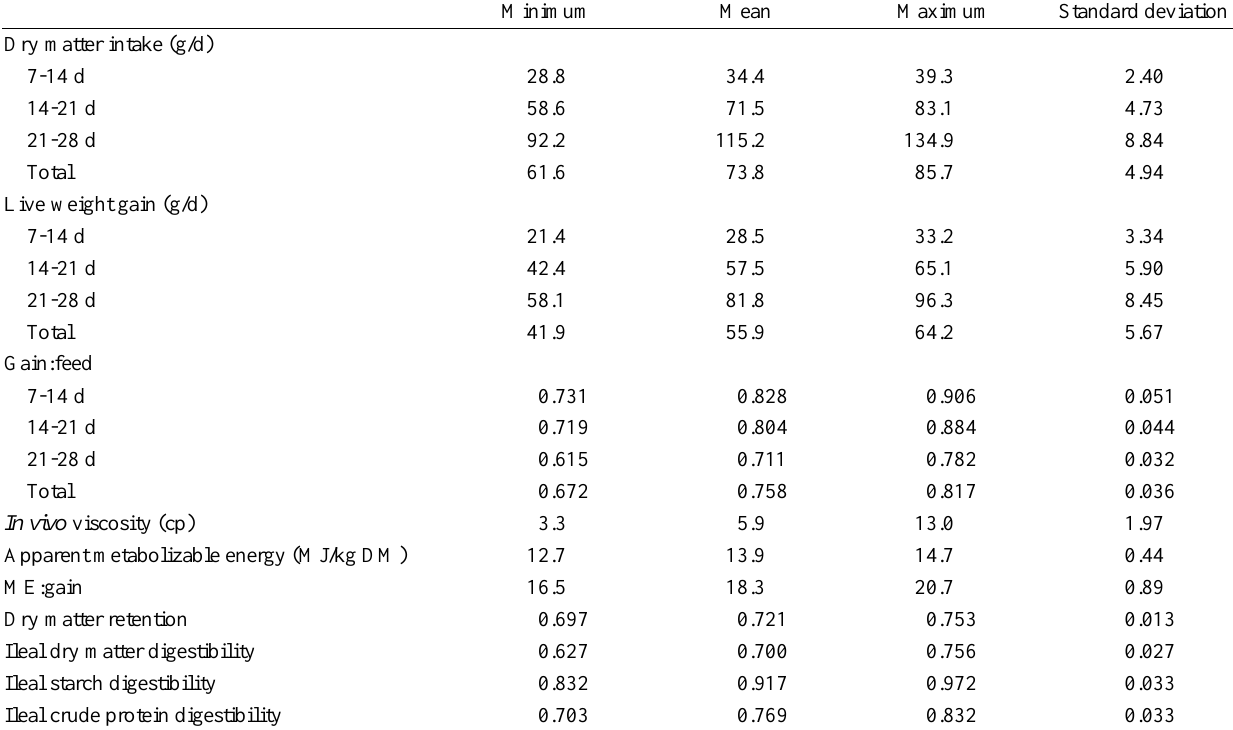
Table 3. Range and standard deviation in broiler performance and nutrient